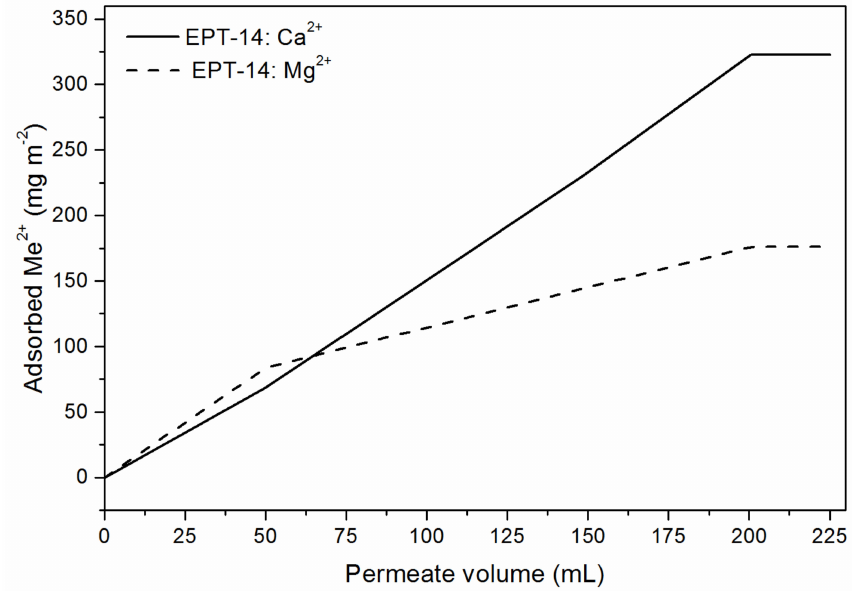
Figure 8. Adsorption of (full line) Ca 2+ and (dashed line) Mg 2+ ions onto an EPT-CNF nanopaper 14 gsm per unit membrane area vs. permeate